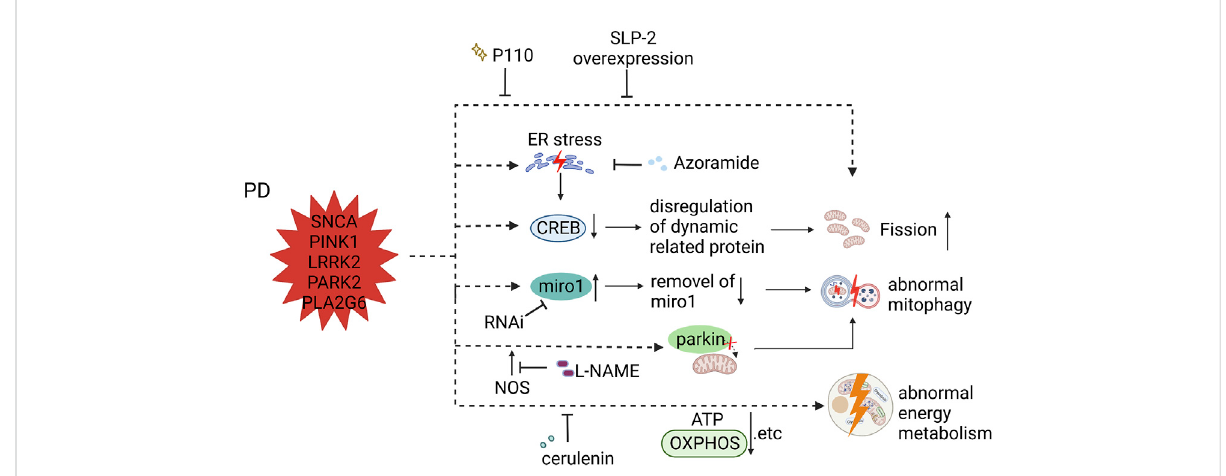
FIGURE 3 Mitochondrial dysfunction in PD iPSC-derived DA neurons (carrying SNCA, PINK1, LRRK2, PARK2, and PLA2G6 mutant) and therapeutic strategies (created with BioRender.com). DA neurons carrying PARK2 and LRRK2 mutants showed fragmented mitochondria, which was compensatedbySLP-2overexpressionandP110.DAneuronswithPLA2G6mutationinducedERstressthatfacilitatedtheunfoldedproteinresponse (UPR),resultingindecreasedsignalingofCREBand fi nalmitochondrialfragments;treatmentwithazoramidealleviatedmitochondrial fi ssionby enhancingtheCERBsignaling.PINK1mutantiPSC-derivedDAneuronspreventedparkinfromtranslocatingtomitochondrialmembrane,resultingin impaired mitophagy; L-NAME ameliorated damaged mitophagy by inhibiting the production of endogenous NOS. Accumulation of miro1 delayed the initiation of mitophagy in both LRRK2 and SCNA iPSC-derived DA neurons, and decreasing the level of miro1 protein by RNAi promotes mitophagy. DA neurons carrying PINK1 mutant displayed reduced levels of ATP production, which was improved by cerulenin through rescuing PINK1 de fi ciency.